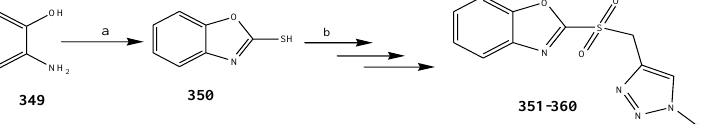
351: Ar = 3,5-di- ClPh; 352 :Ar = 4-ClPh; 353 :Ar = 4-FPh; 354 :Ar = 4-BrPh; 355 :Ar = 3,5-di-Me-Ph; 356 :Ar = 3-NO 2 - Ph; 357 :Ar = 4-OMePh; 358 :Ar = 3-ClPh; 359 :Ar = 4-EtPh; 360 :Ar = 2,3-di-MePh. Scheme 29. Synthetic route of oxazole from hydroxyl aniline. a = CS 2 /KOH/Reflux, b = Propargylbromide/K 2 CO 3 / m- CPBA/ArN 3 /CuI/[Bmim]PF 6 .